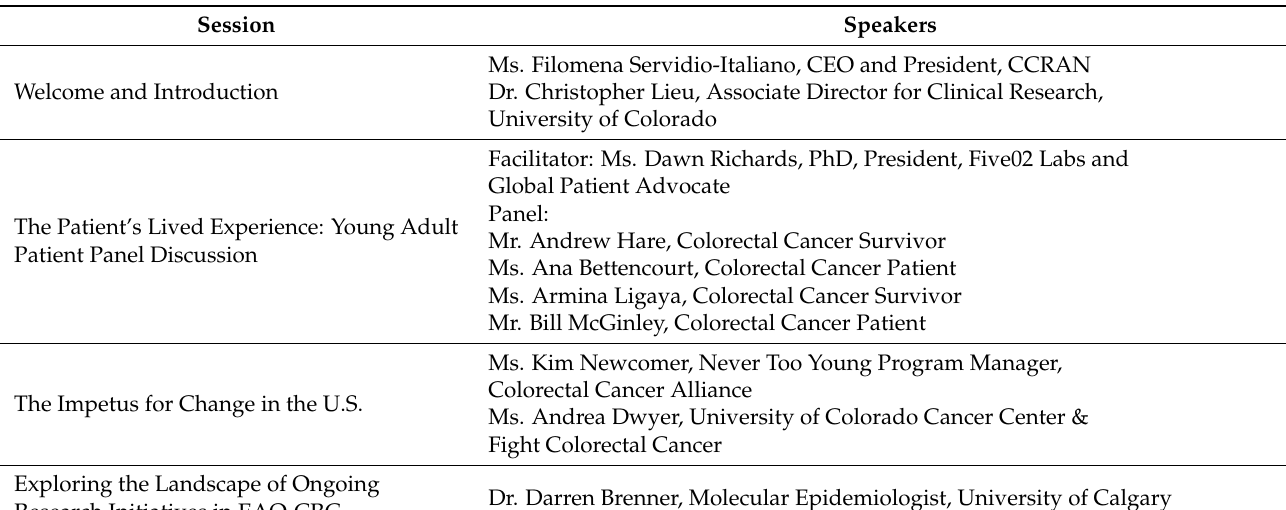
Table 1. EAO-CRC Symposium